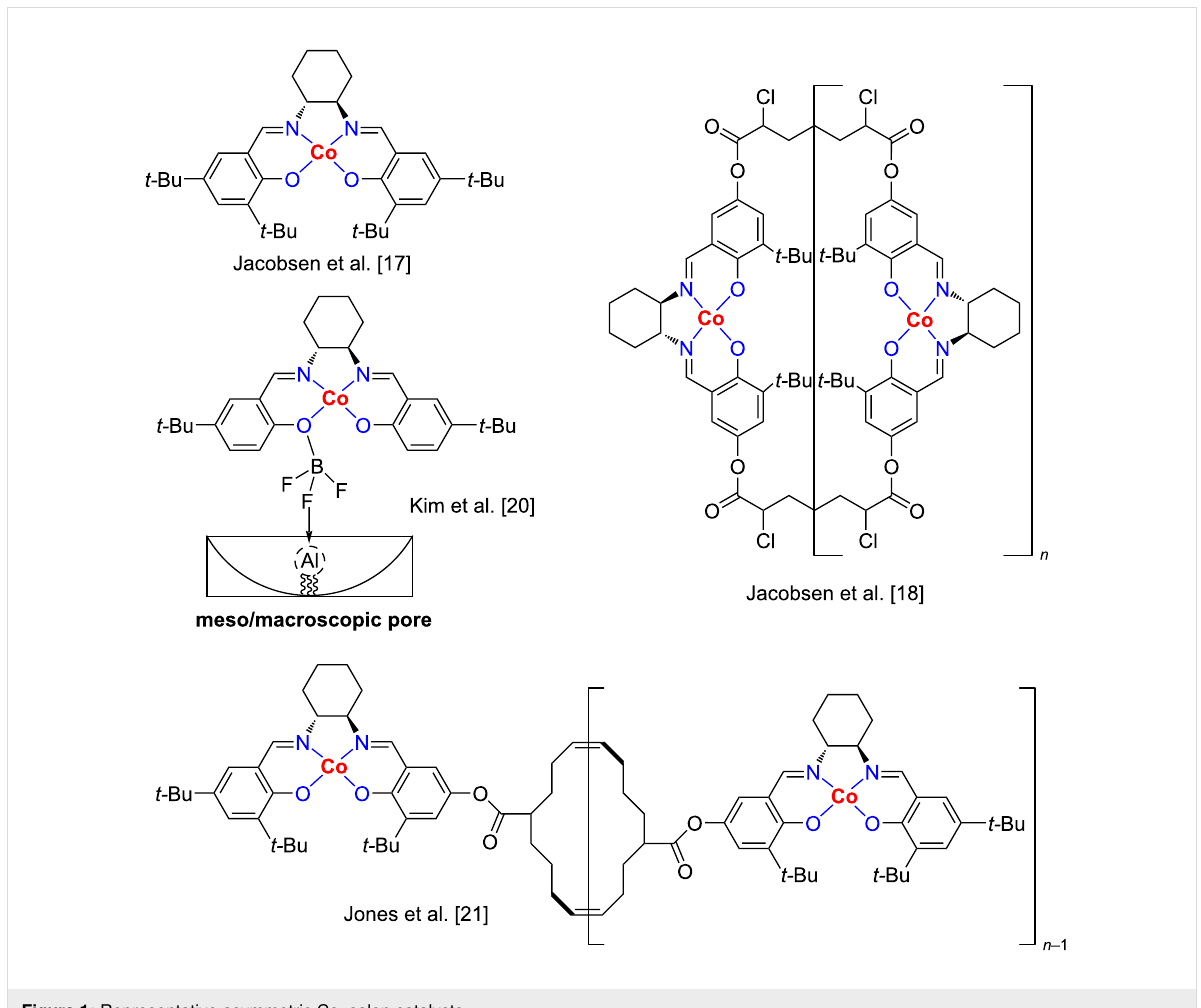
Figure 1: Representative asymmetric Co–salen